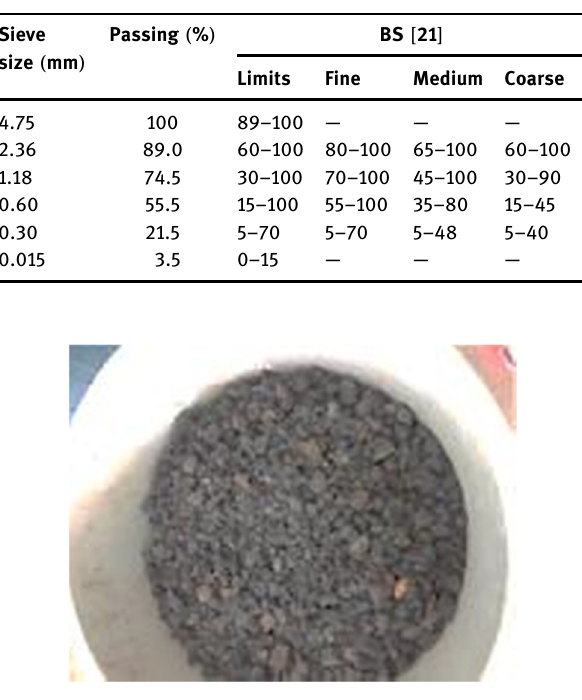
Table 4: Sieve analysis of fi ne aggregate used and speci fi cation